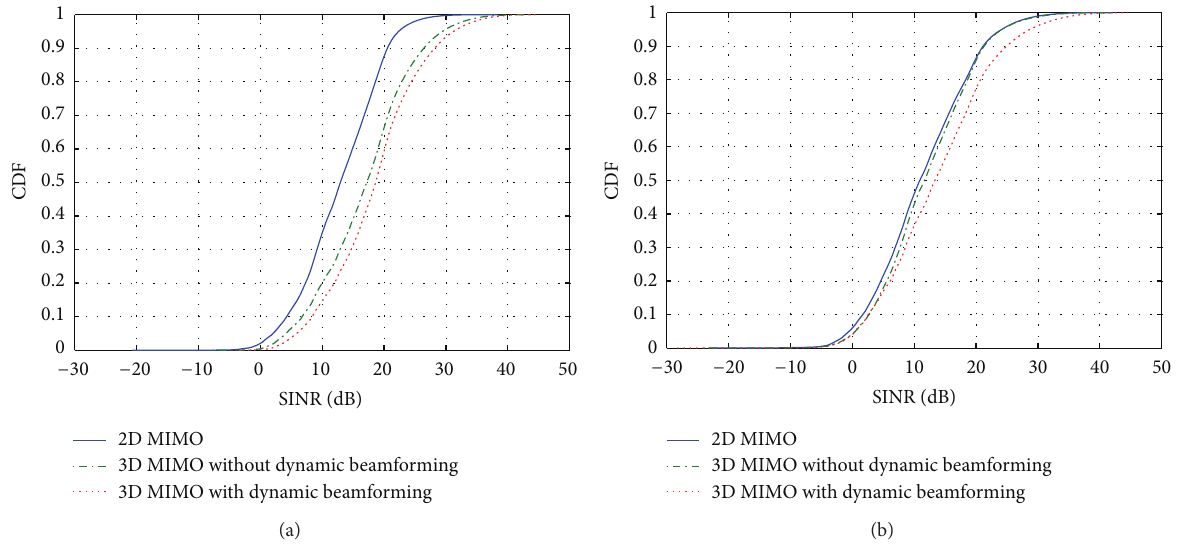
Figure 9: System level results of receive SINR CDF for 2D MIMO, 3D MIMO without dynamic beamforming and 3D MIMO with dynamic beamforming: (a) sector radius: 288 m; (b) sector radius: